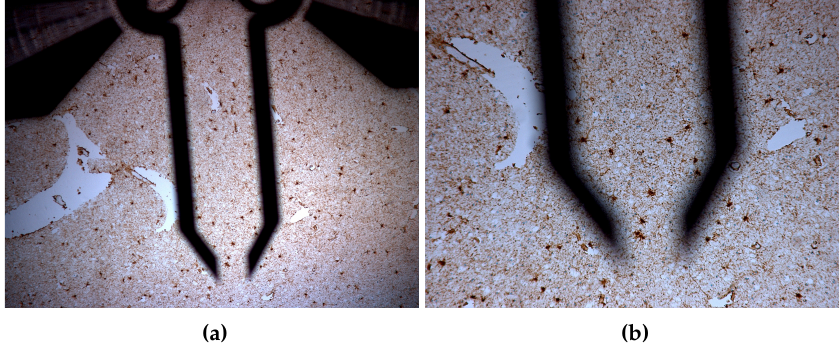
Figure 16. Brain tissue and gripper at different focus distances. ( a ) Brain (Focus a); ( b ) Brain (Focus b).